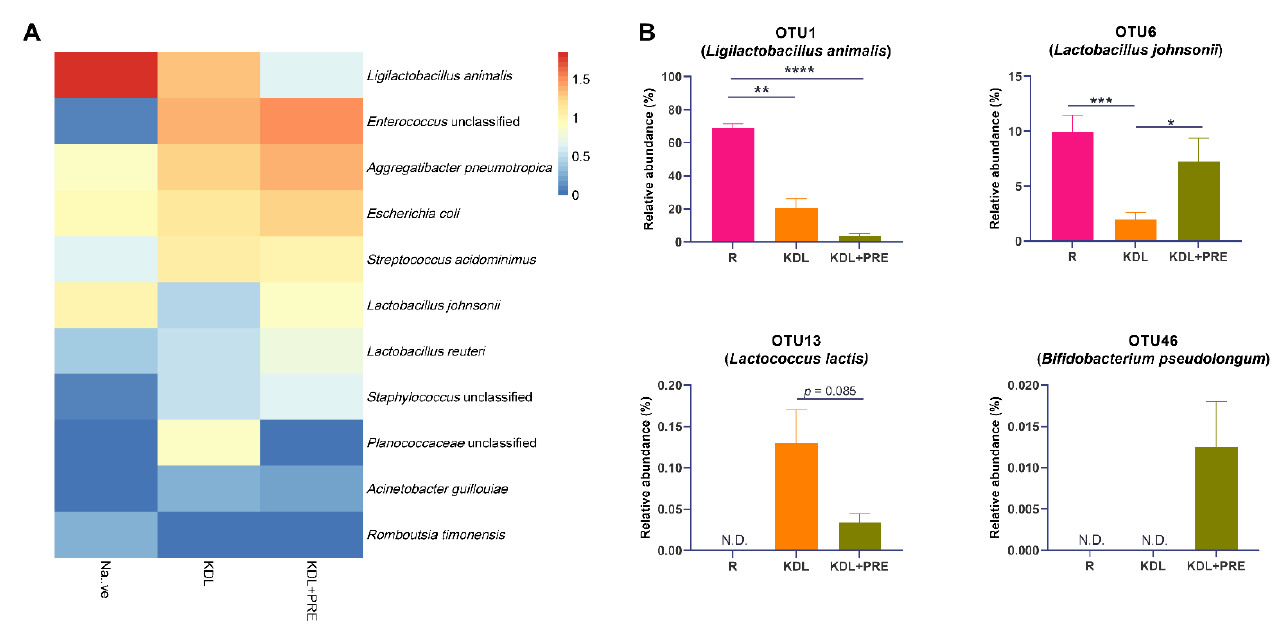
Figure 6. Effects of prebiotic inclusion on gut microbiota composition. ( A ) Heatmap of the predom- inant species. Data are presented as means. ( B ) Species with significant alterations. R-normally developing reference group; KDL-ketogenic diet formula; KDL+PRE-ketogenic diet formula plus prebiotic fiber. Data are presented as mean ± SEM. n = 10-11 rats/group. * p < 0.05, ** p < 0.01, *** p < 0.001, **** p < 0.0001.